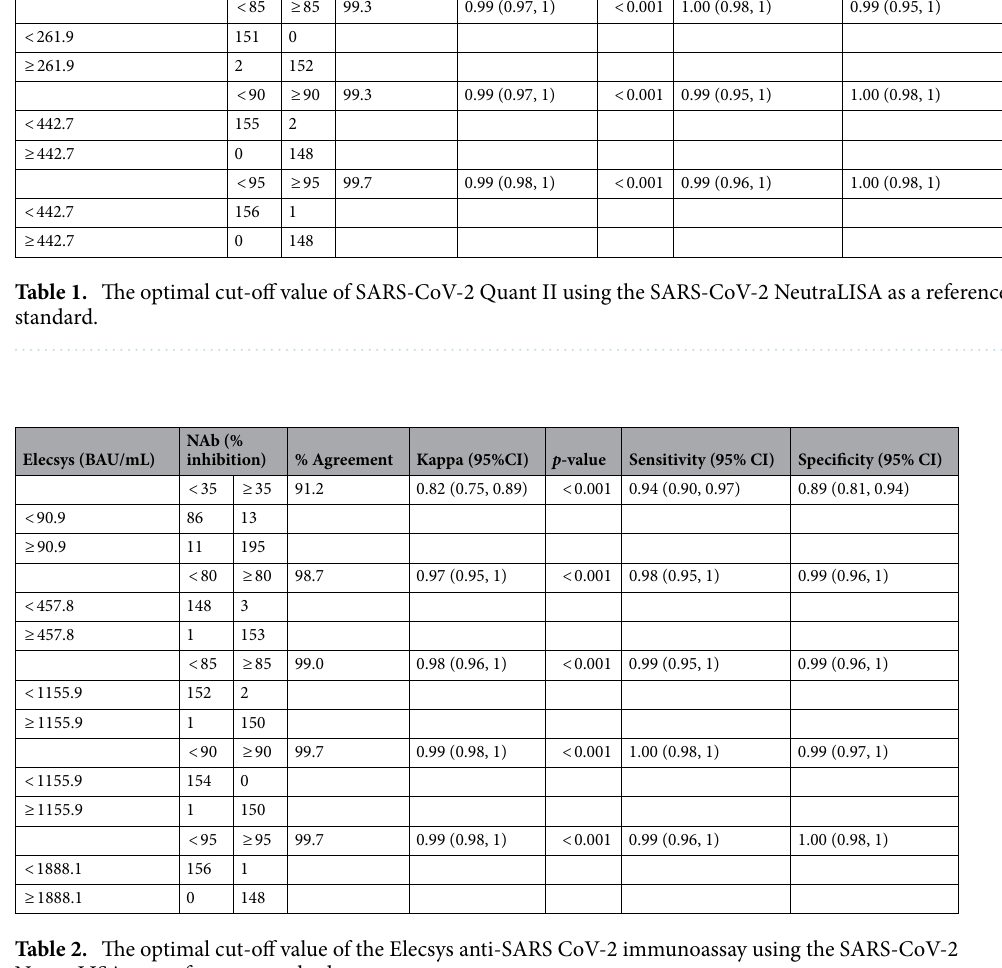
some scattered results away from the regression line at 30–70% inhibition. There were satisfactory results of the in-house ELISA and also in-house sVNT with the commercially available tests. These tests may be cost effective alternative ways of detecting antibodies with acceptable performance. Several studies showed that vaccine efficacy and vaccine effectiveness correlated with neutralizing antibody levels for protection against symptomatic COVID-19 infection 9,24,30 . Protection against severe disease required lower neutralizing antibody levels than those conferring protection against mild disease 9 . Predictive models identifying a mean neutralization titer (relative to convalescent) of 1 correlate with 80% protective efficacy against SARS-CoV-2 infection, mostly due to SARS-CoV-2 variant B.1.177 24 . That study predicted vaccine efficacy against symptomatic infection of 50%, 60%, 70%, 80%, and 90% with the level of anti-spike IgG, anti-RBD IgG, normalized live-virus neutralization assay and pseudovirus neutralization assay respectively 24 . For example, 80% vaccine efficacy against symptomatic COVID-19 infection with mostly B.117 variants of SARS-CoV-2 was achieved with anti-spike IgG of 40,923 AU/mL, and 264 BAU/mL and anti-RBD-IgG of 63,383 AU/ml, and 506 BAU/mL, and NF50 for normalized live-virus neutralization assay of 247, and ID50 for pseudovirus neutraliza- tion assay of 57. No data to compare the vaccine efficacy and % inhibition of sVNT was published in that study. However, a correlation between sVNT and virus neutralization test (the plaque-reduction neutralization test; PRNT) has been reported 31 .